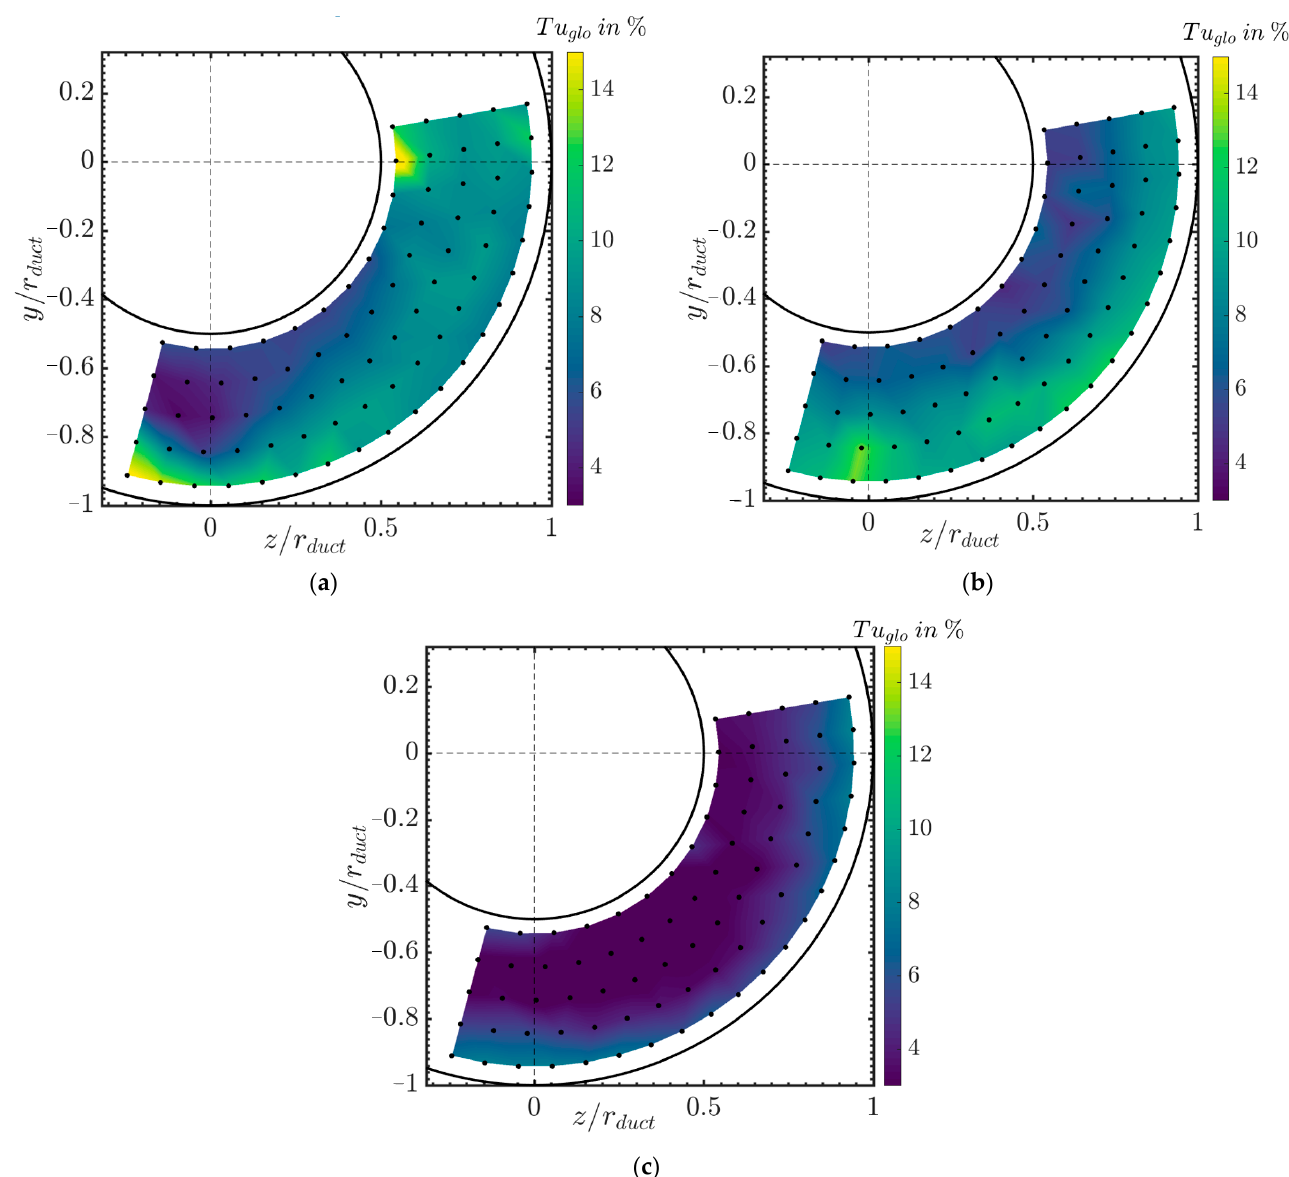
Figure 11. Comparison of the turbulence level between heat exchanger, imitated flow field by active turbulence grid and the undisturbed inflow at a volume flow rate of V = 1.4 m 3 /s. ( a ) Flow field behind a real heat exchanger, ( b ) flow field reproduced by ATG and ( c ) free, undisturbed inflow.